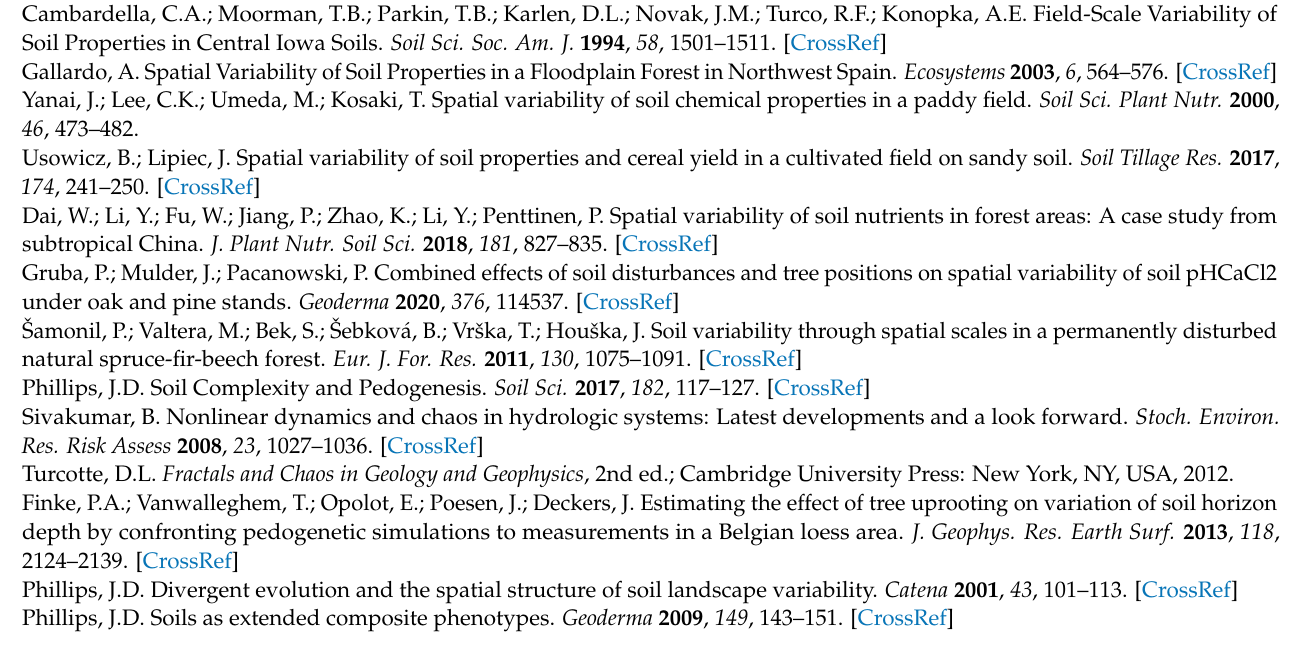
Boxplots of the soil chemical concentrations, both in the surface and subsurface layers, in the study area. Figure S6: Vertical distribution of bulk density in Haplic, Dystric Cambisols, and Albic and Entic Podzols. Figure S7: Histograms of treethrow depth measured in the study area. Figure S8: Redundancy analysis (RDA). Ordination diagram (triplot) showing the significant relationships of Table 6. Sites (denoted by points), explanatory variables (treethrow density and treethrow depth; red arrows), and response variables (soil properties; blue arrows). First axis is horizontal, second axis is vertical. The angles among arrows denote the degree of correlation between the individual variables; the smaller the angle, the larger the correlation. In addition, positively correlated variables are shown as arrows pointing in the same direction, while negatively correlated variables point in opposite